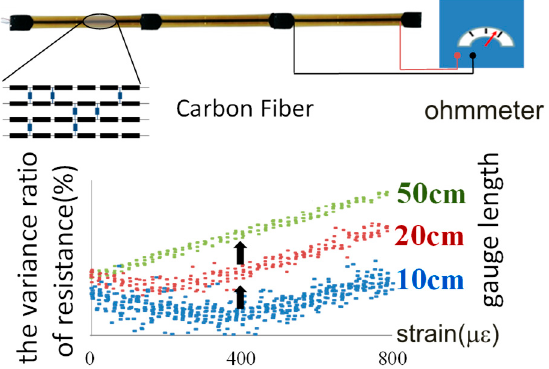
Figure 2. Techniques for long gauge carbon fiber sensing.